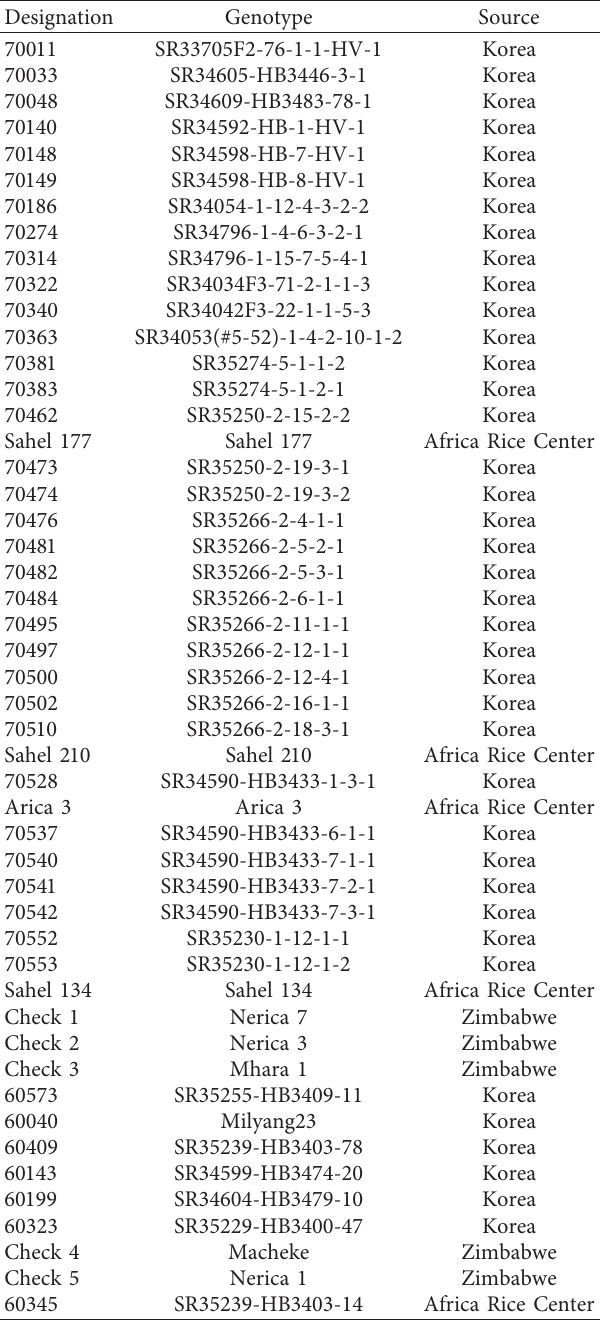
Table 2: List of plant materials used in the